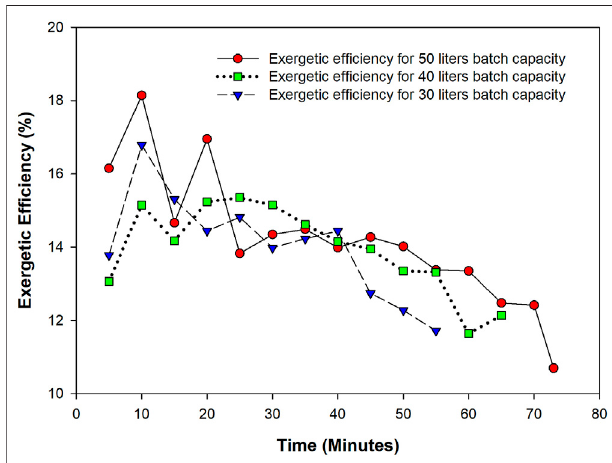
FIGURE6| Exergyef fi ciencyduringthecoolingprocessofyogurtfor50, 40, and 30 L batch capacities.